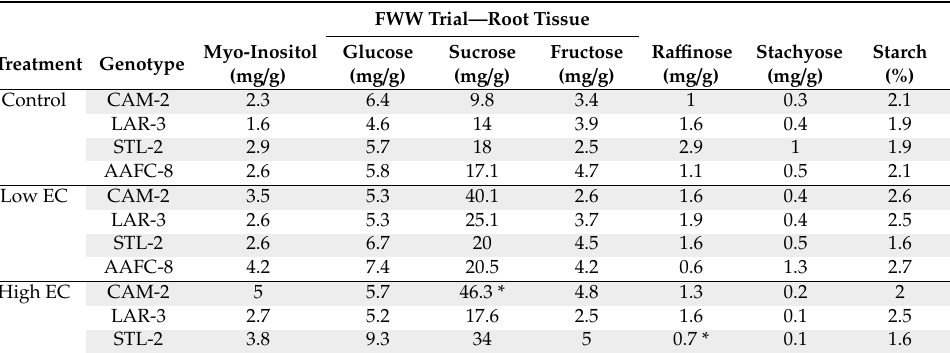
Table 6. Soluble sugar content of willow and hybrid willow leaf tissues at the conclusion of the FWW trial treated with control, low, and high fracking wastewater treatments ( n = 3 for genotypes and treatments). Asterisks indicate significant treatment e ff ect compared to control ( p < 0.05). AAFC-8 is omitted at the high fracking concentration due to limitations in available